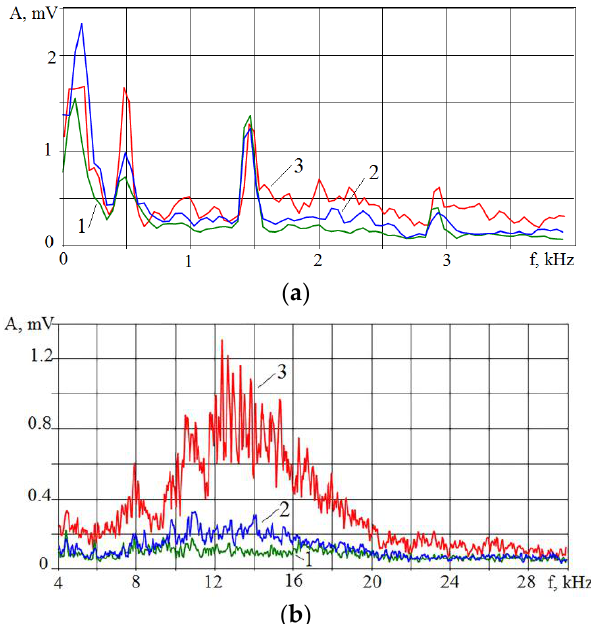
Figure 6. Spectra of the VA signal in the low-frequency ( a ) and high-frequency ( b ) ranges during melting of the AISI 410 powder layer with the different laser beam velocities: ( 1 ) 10 mm/s; ( 2 ) 25 mm/s; ( 3 ) 50